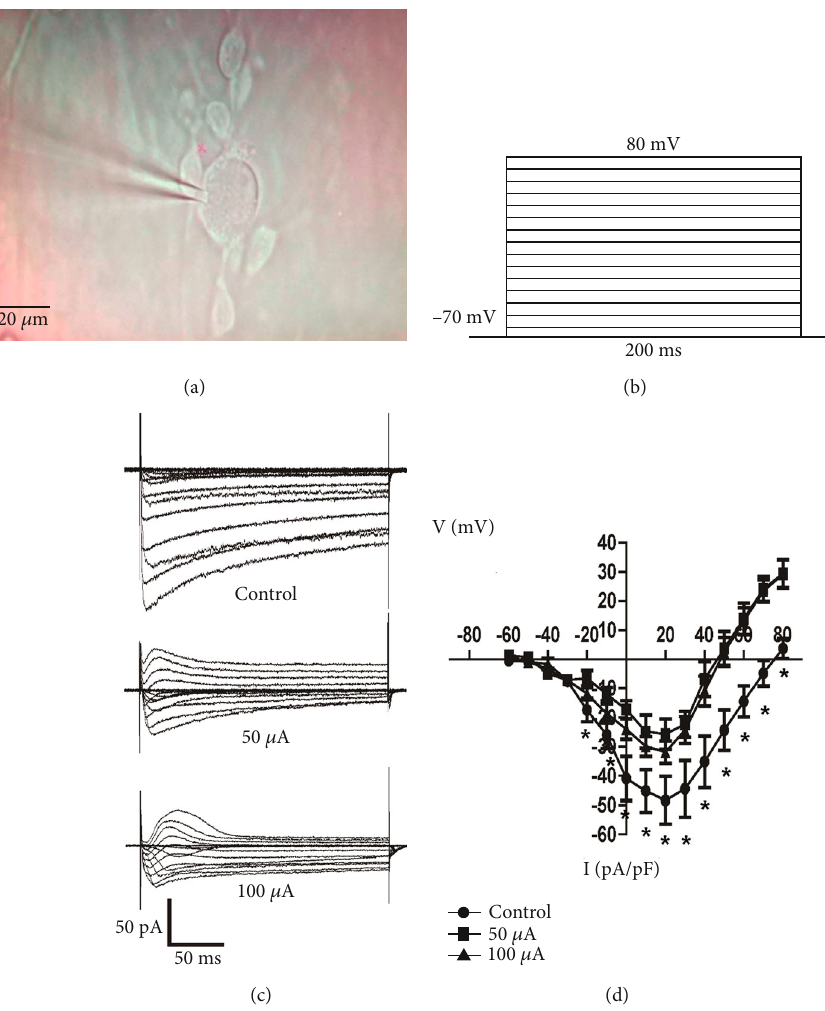
Figure 2: Electrical stimulation decreases voltage-dependent calcium currents ( I microelectrode. (b) The stimulation parameters of voltage-dependent calcium current. (c, d) The inhibitory e ff ect of electrical stimulation was obvious when the membrane potential was depolarized with the step ranging between 0mV and +80mV. The I -60 mV and reached the peak at 20 mV, the reversal potential of I stimulation could change the reversal potential to +47 : 5 mV ± 3 : 497 and +46 : 3 mV ± 4 : 369 in 50 μ A and 100 μ A groups ( p < 0 : 05